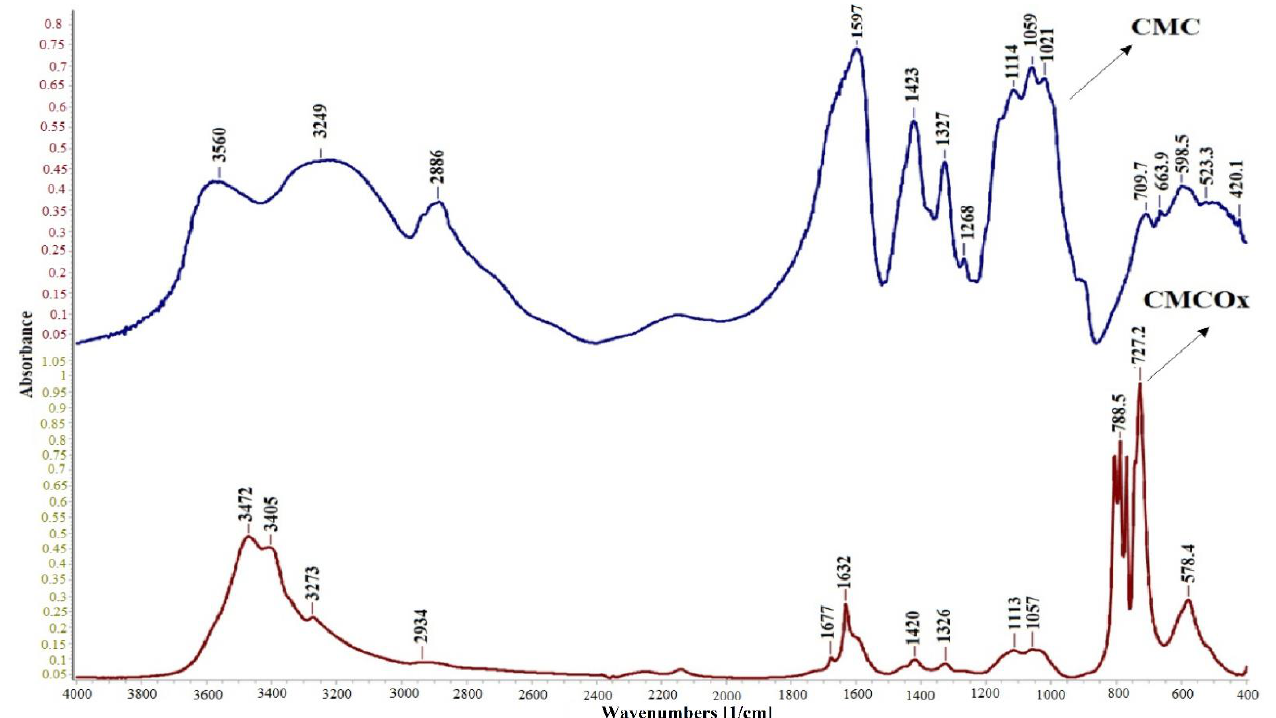
Figure 1. Fourier-transform infrared (FTIR) spectra for carboxymethyl cellulose (CMC) and oxidized carboxymethyl cellulose (CMCOx)- the time used for the oxidation was 6 h .